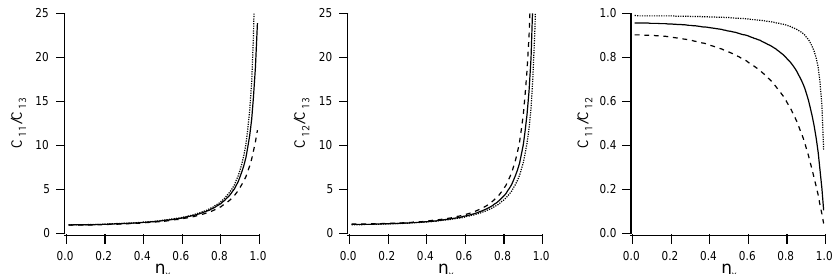
FIG. 1. The relative oscillation amplitude in breathing oscillation cases. Three different j have been considered, i.e., j (cid:1) 0.075 (dotted line), j (cid:1) 0.15 (solid line); and j (cid:1) 0.225 (broken line).